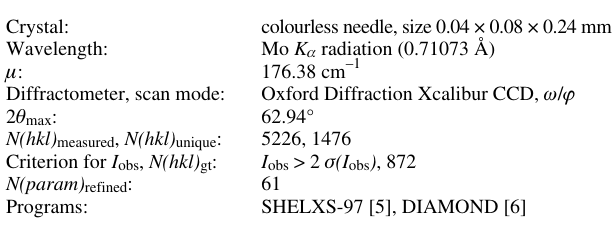
Table 1. Data collection and handling.